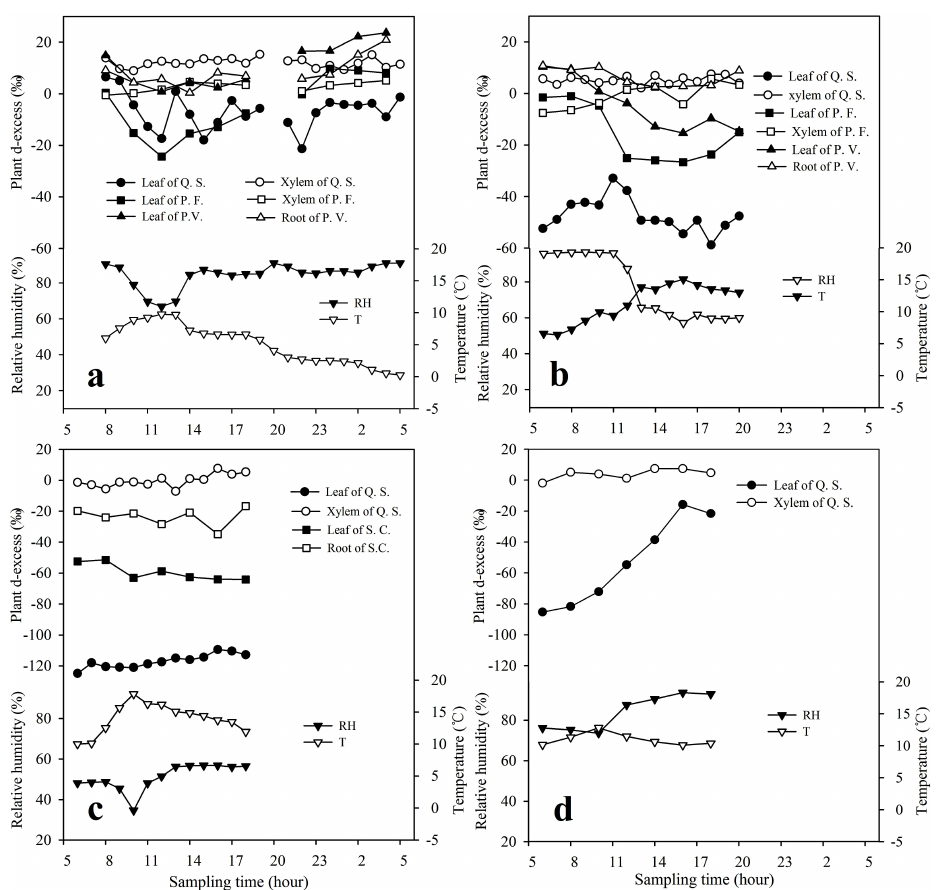
Figure 7. Variations in leaf and xylem water d-excess of the upper reaches of the Heihe River basin during the cloudy days. Note: panels (a) , (b) , (c) and (d) refer to the same location as in Fig. 2, and the abbreviations of plant Latin names were the same as in Table